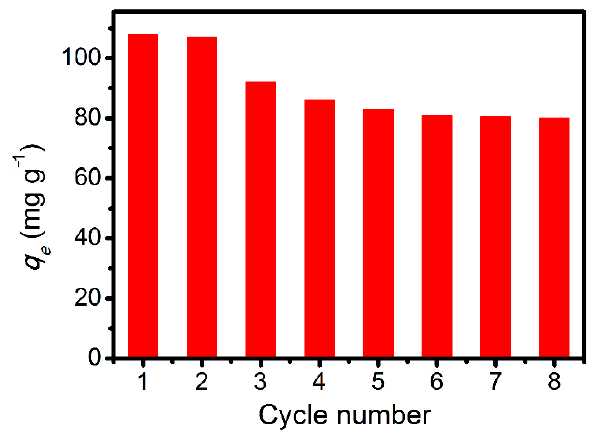
Figure 6. The recycling performance of GO15-MIL-101(Fe) in the removal of U(VI) from aqueous solution ( C 0 = 10 mg L − 1 , pH = 5.5, T = 298 K, m / V = 0.2 g L − 1 , and I NaNO